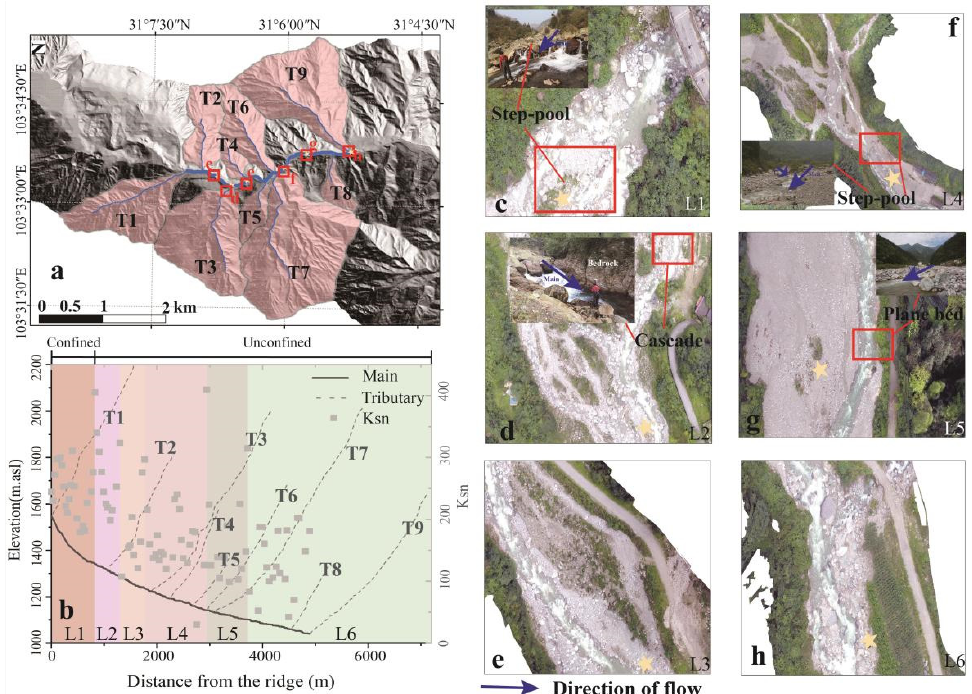
Figure 4. Division of the study channel in Longxi River: ( a , b ) showed the study channel’s division in Longxi River. L1–L6 represents the different parts along the main channel, and the T1–T9 represents the different tributaries along the river. ( c – h ) displayed the characteristics of different parts by the UAV image taken on 4 July 2018.